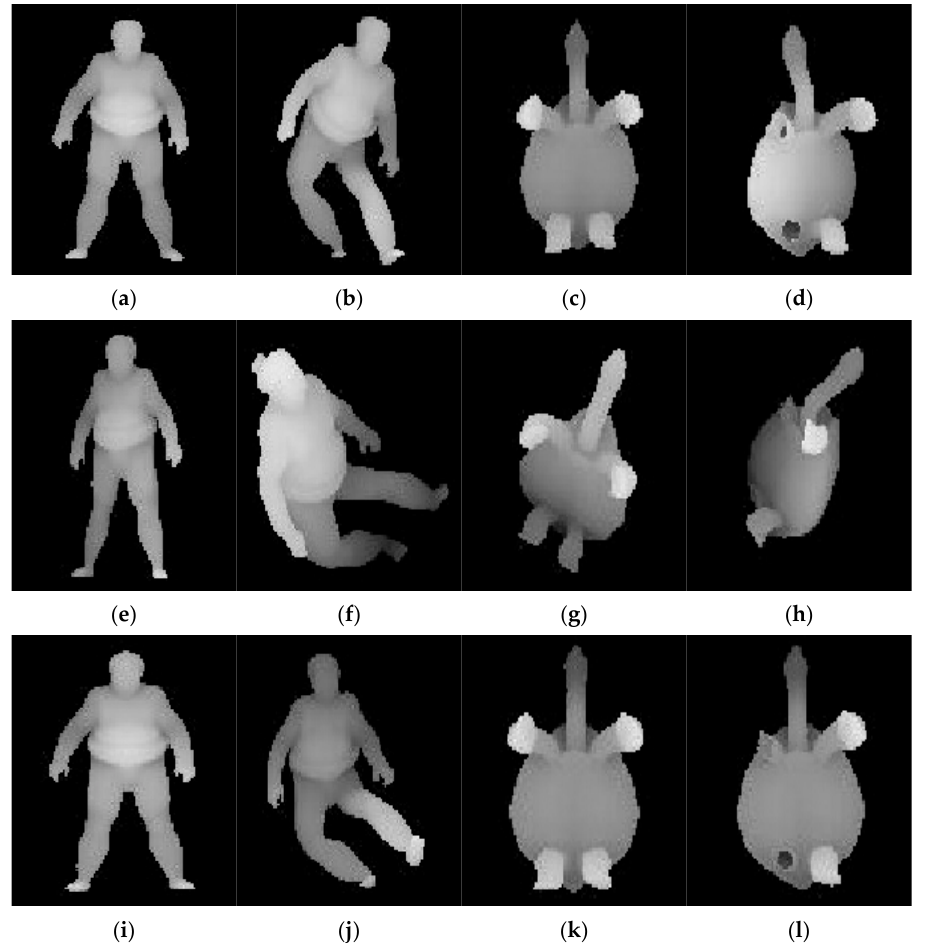
Figure 4. The most representative range images of shape normalized models using PCA ( a – d ): original and deformed sumotori model, original and partially removed tortoise model; ISR ( e – h ): original and deformed sumotori model, original and partially removed tortoise model; and WISR ( i – l ): original and deformed sumotori model, original and partially removed tortoise model.